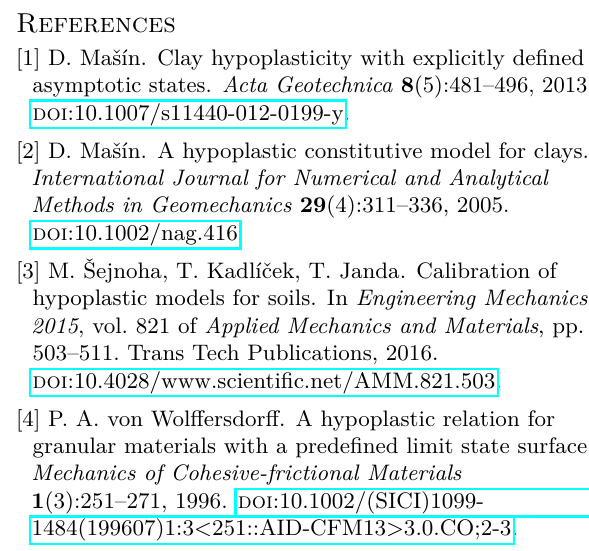
Figure 6. Correlations between HC parameters and index